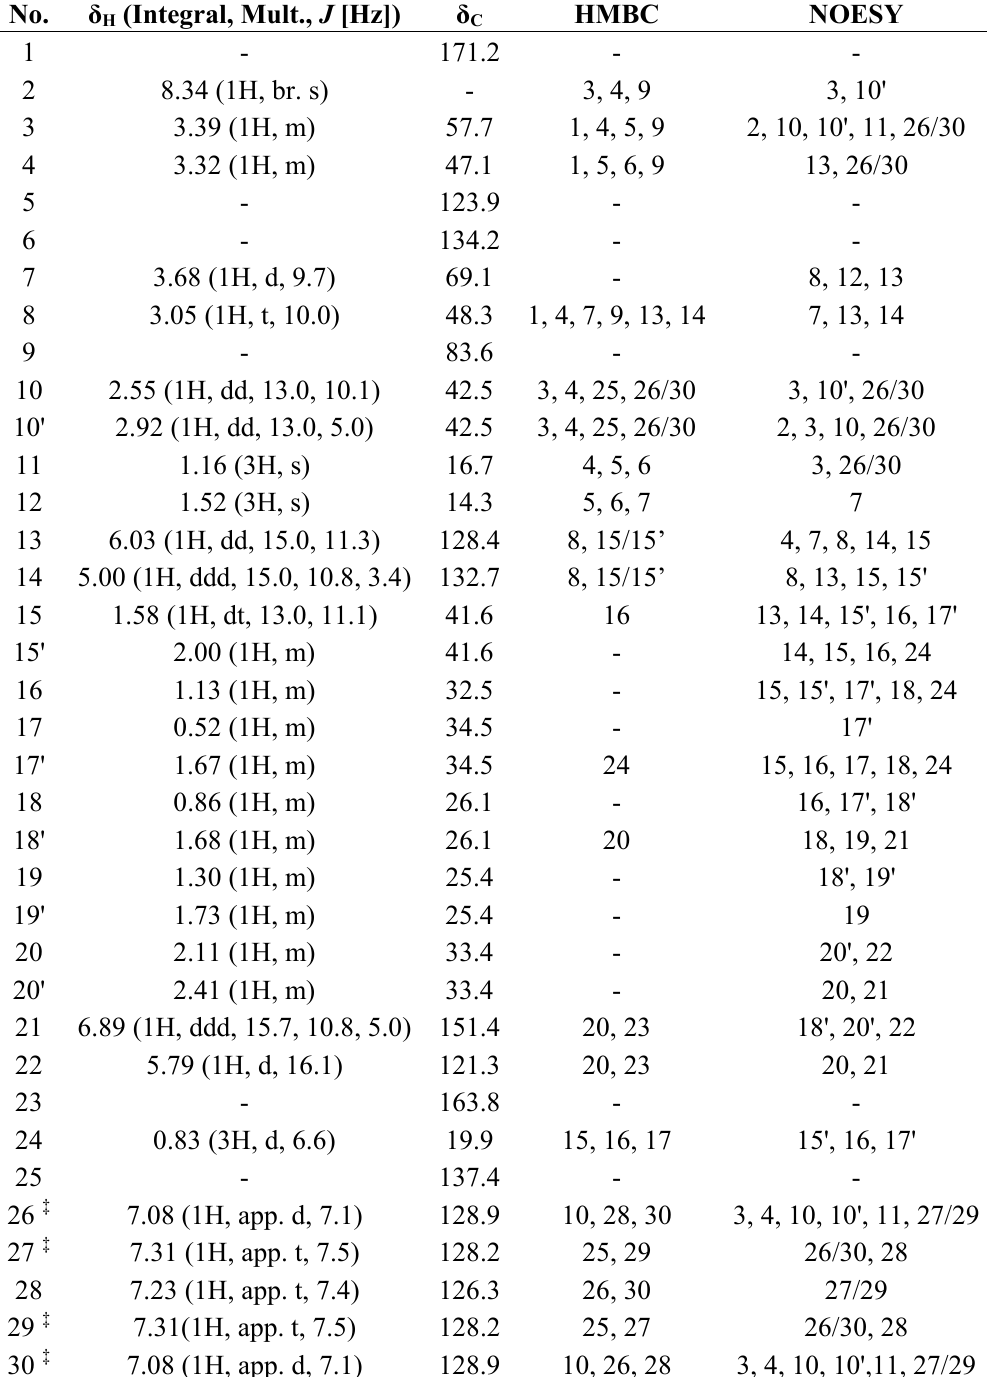
Table 2. NMR data for sclerotionigrin B (2) †